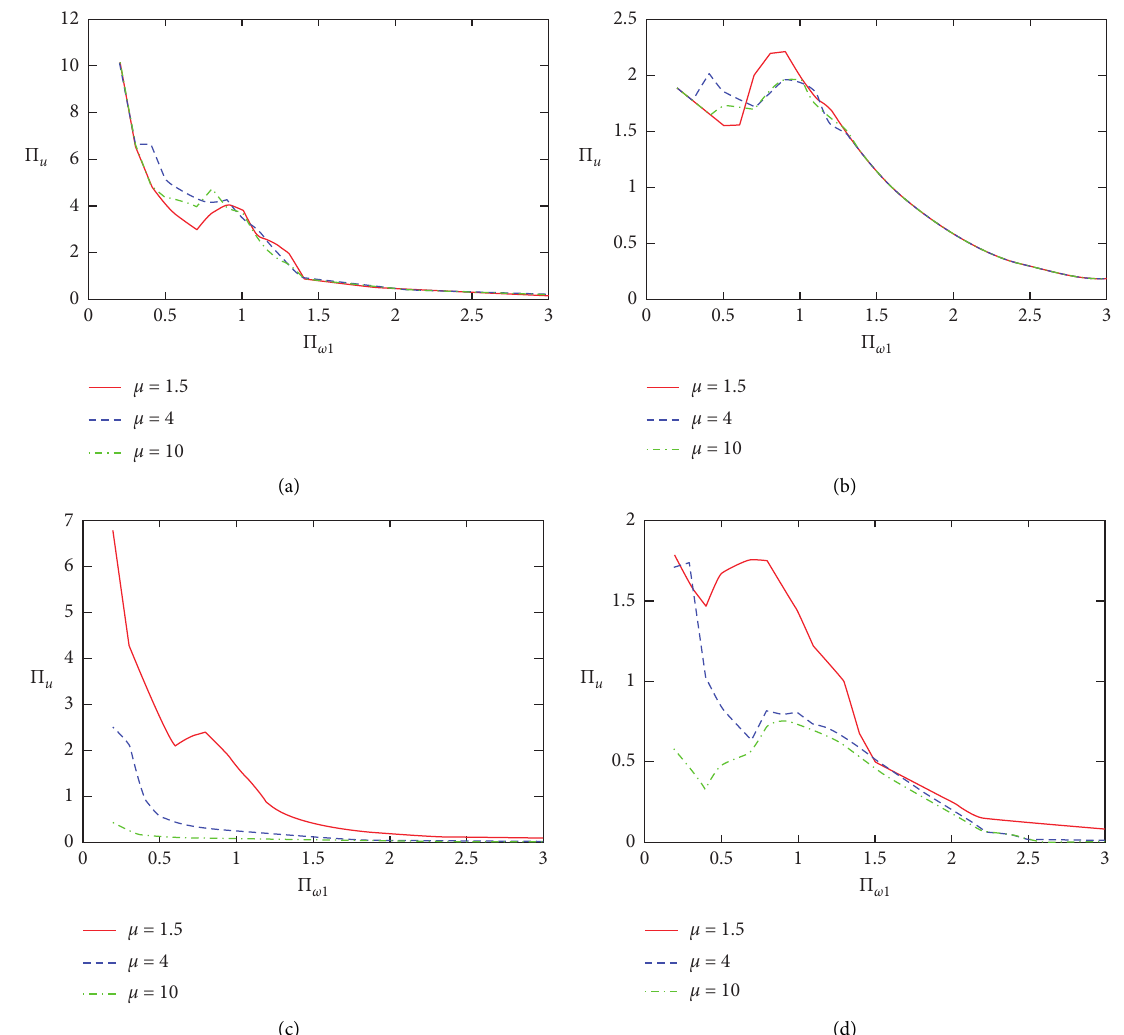
Figure 9: Maximum dimensionless displacement Π u and velocity Π v versus Π ω 1 for various mass ratios Π m ( Π � 0 . 05 , Π � 0 . 9 Π � 0 . 8 , Π � 0 . 9 , μ � 1 . 5 , Π � 0 . 1 , Π � 50 , Π � 0 . 4 , Π � 0 . 2 ) . (a) Maximum dimensionless displacement uy 1 uy 2 uy 1 r d ξ α ω con Π u of left-side structure. (b) Maximum dimensionless velocity Π v of left-side structure. (c) Maximum dimensionless displacement Π u of right-side structure. (d) Maximum dimensionless velocity Π v of right-side